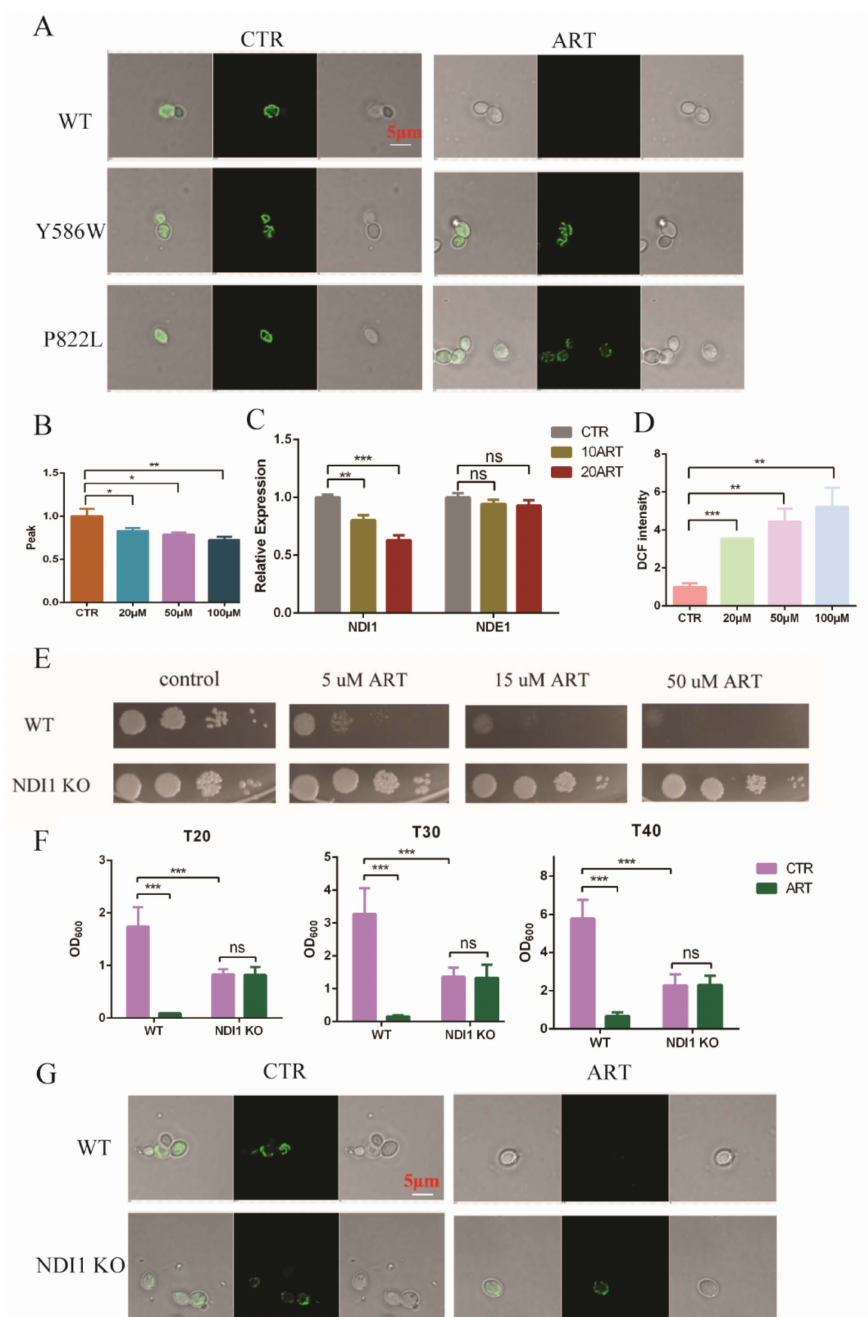
Figure 5. Mitochondria was disrupted with artemisinin. ( A ) Artemisinin depolarized C. glabrata mitochondrial membrane potential. ( B ) Artemisinin increased mitochondrial membrane viscosity of C. glabrata . ( C ) Ndi1 expression was downregulated by artemisinin. ( D ) Artemisinin enhanced ROS level in C. glabrata . ( E ) Ndi1 KO strain was resistant to artemisinin by spot assay. Four dots mean 10-fold serial dilutions of yeast cells. ( F ) The growth of Ndi1 KO strain had no significant change with artemisinin in liquid medium. Data are mean ± SD of three independent experiments. Data were analyzed by GraphPad Prism. * p -value < 0.05, ** p -value < 0.005, *** p -value < 0.0005 and ns means no significant change ( p -value > 0.05). ( G ) Ndi1 KO strain had a lower mitochondrial membrane potential but could not be depolarized by